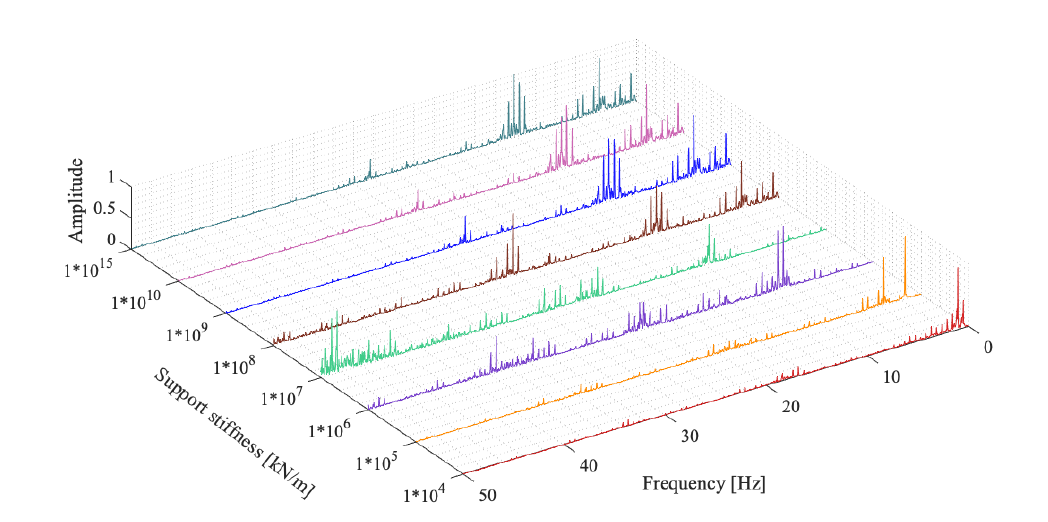
Figure 9. Fourier Amplitude Spectrum of the acceleration time history response at the mid-span for a train speed of 80 km/h. Different colors correspond to different bearing stiffness